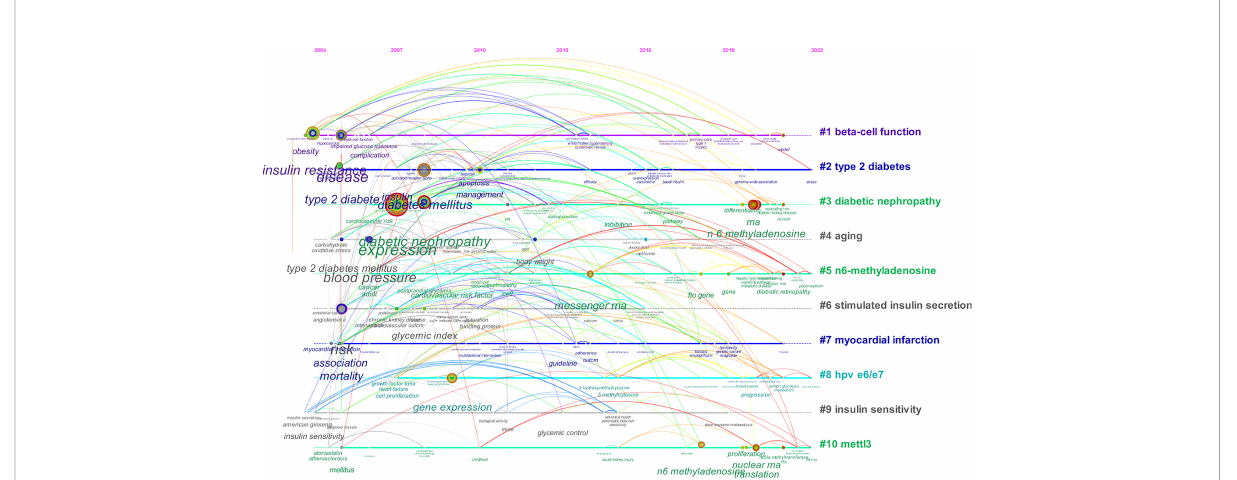
FIGURE 11 CiteSpace visualization timeline view of keywords clustering analysis related to RNA methylation in DM and its complications. The different colored horizontal lines with the label on the right represent the clusters formed by the keywords, the nodes on the horizontal lines represent the keywords, and the position of the nodes on the horizontal lines represents the year in which the literature containing the keywords fi rst appeared, thus forming the timeline of the keywords cluster